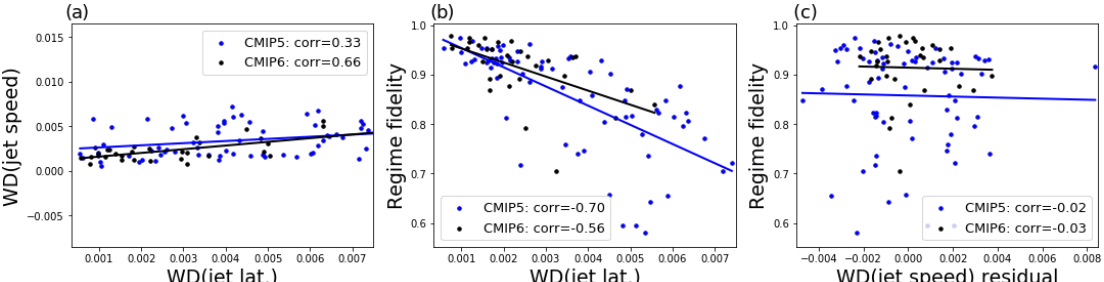
Figure 9. (a) Correlations between the Wasserstein distances in jet latitude and jet speed in each climate model simulation. (b) The same but showing correlation between Wasserstein distance in jet latitude and the fidelity of the three geopotential-jet regimes. (c) The correlation between regime fidelity and the residual of the jet speed distance after co-variability with the jet latitude distance has been regressed out. Correlations in panels (a) and (b) are significant at the 1% level, while no significant correlations are present in panel (c) .